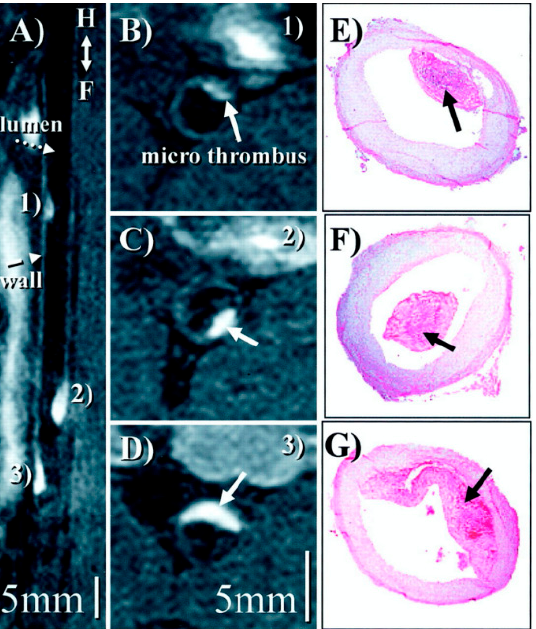
Fibrin Fibrin plays a crucial role during plaque progression, development of intraplaque haemorrhage and formation of thrombus following plaque rupture [71,72]. It is therefore an important target for molecular imaging of atherosclerotic plaque. Yu et al. demonstrated the feasibility of molecular MRI of fibrin clots ex vivo using a novel fibrin-targeted contrast agent with a lipid-encapsulated perfluorocarbon nanoparticle incorporating numerous Gd-DTPA complexes into its outer surface [73]. The ability to visualise human clots of variable sizes (0.5–7.0 mm) ex vivo was significantly improved after administration of this contrast agent compared to non-contrast T1 weighted imaging. In another study, the use of fibrin-specific paramagnetic nanoparticles enabled e ffi cient targeting and signal enhancement of thrombi in the external jugular vein of a canine model in vivo [74]. Instead of nanoparticles, Sirol et al. used a gadolinium-based, small molecular weight, fibrin-binding MRI agent (EP-1242; EPIX Pharmaceutical) to image acute carotid plaque thrombus in guinea pigs [75]. Later on, Botnar et al. demonstrated the feasibility of in vivo molecular MRI of acute and subacute plaque thrombosis following plaque rupture using the gadolinium-based fibrin-binding MRI contrast agent (EP-1873) in a rabbit model of plaque rupture and thrombosis [76] (Figure 10). The same group also demonstrated the feasibility of acute coronary thrombus detection using a similar gadolinium based fibrin-binding contrast agent, EP-2104R, in a swine model [77] (Figure 11). EP-2104R was subsequently successfully translated into humans, demonstrating the in vivo potential of this fibrin-specific MRI contrast agent for the detection of acute venous and arterial thrombus in patients for the first time [78,79] (Figure